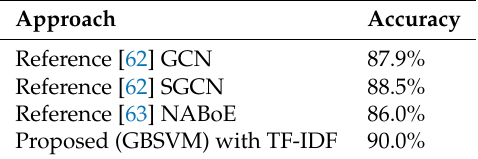
Table 8. Performance comparison of GBSVM against